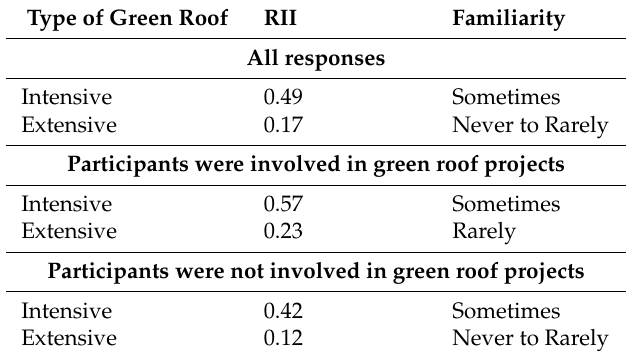
Table 4. Presence of green roofs in Dhaka.